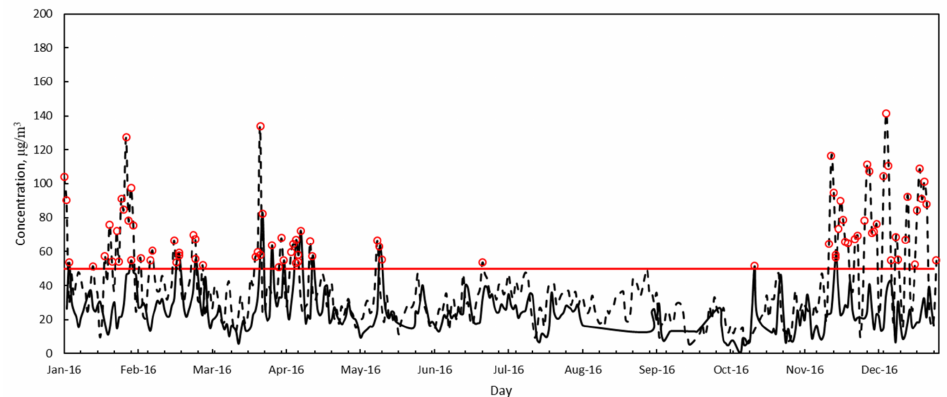
Figure 3. PM10 daily average concentrations measured in the HI (dashed black line) and LI (solid black line) area during 2016 from the ARPAC network. Exceedance from the law limit according to the D.Lgs. 55/2010 (solid red line) is represented by red dots.